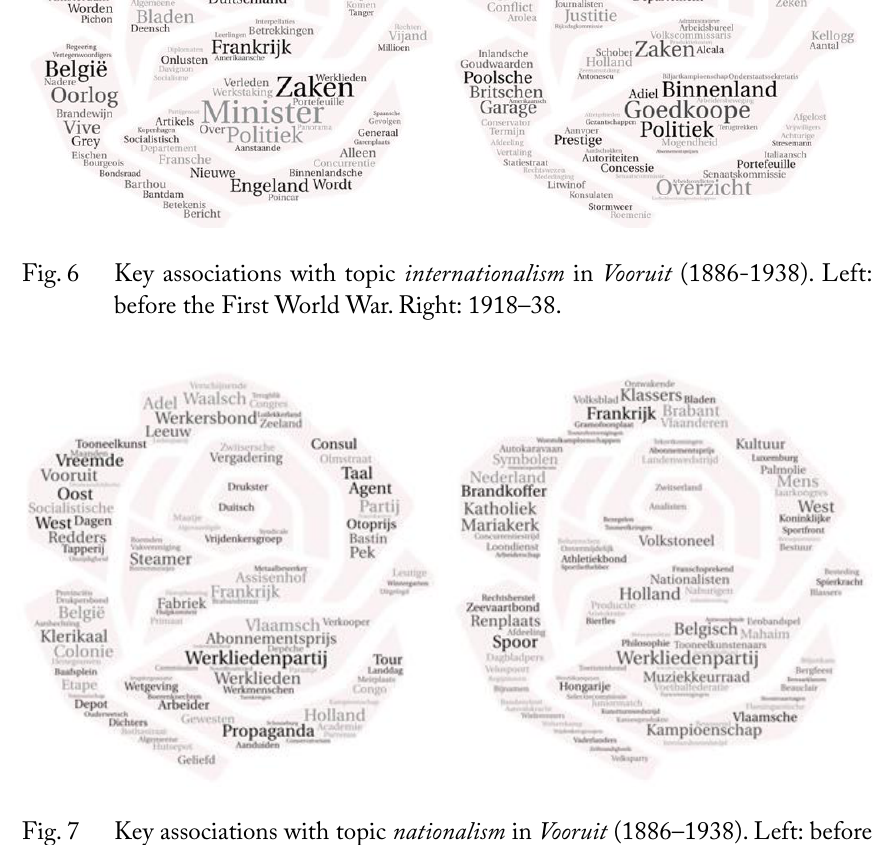
Fig. 7 Key associations with topic nationalism in Vooruit (1886–1938). Left: before Figure 7: Key associations with topic nationalism in Vooruit (1886-1938). Left: before WW 1. Right: 1918-1938. the First World War. Right: